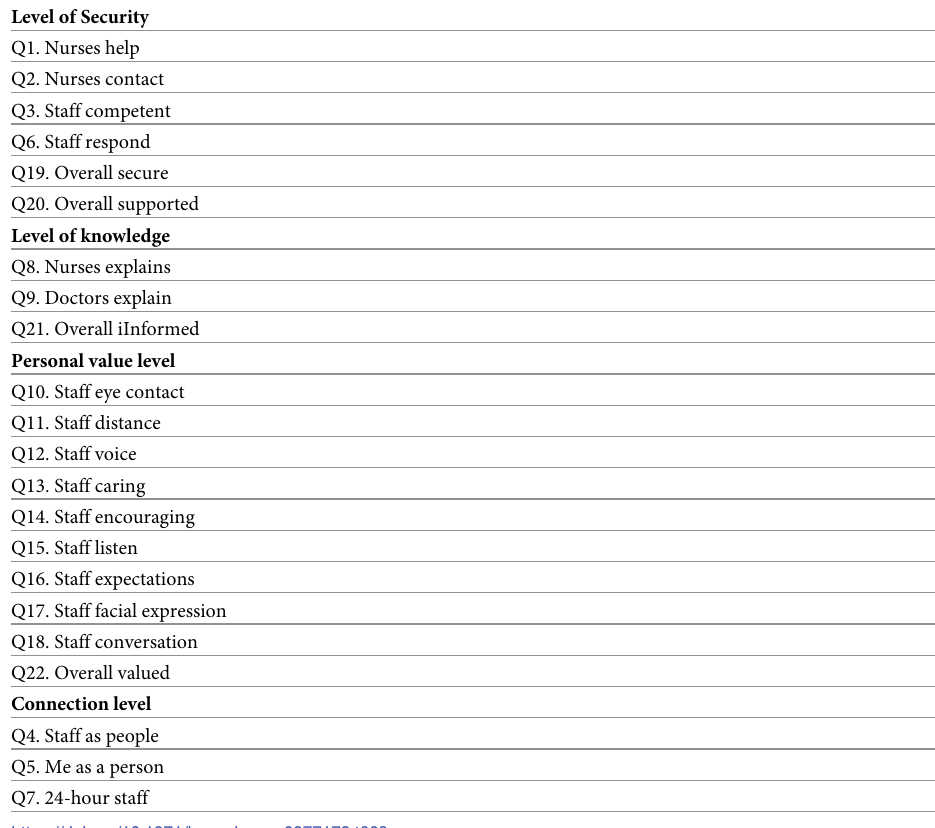
Table 3. Sub-scales of the PEECH questionnaire for ICU